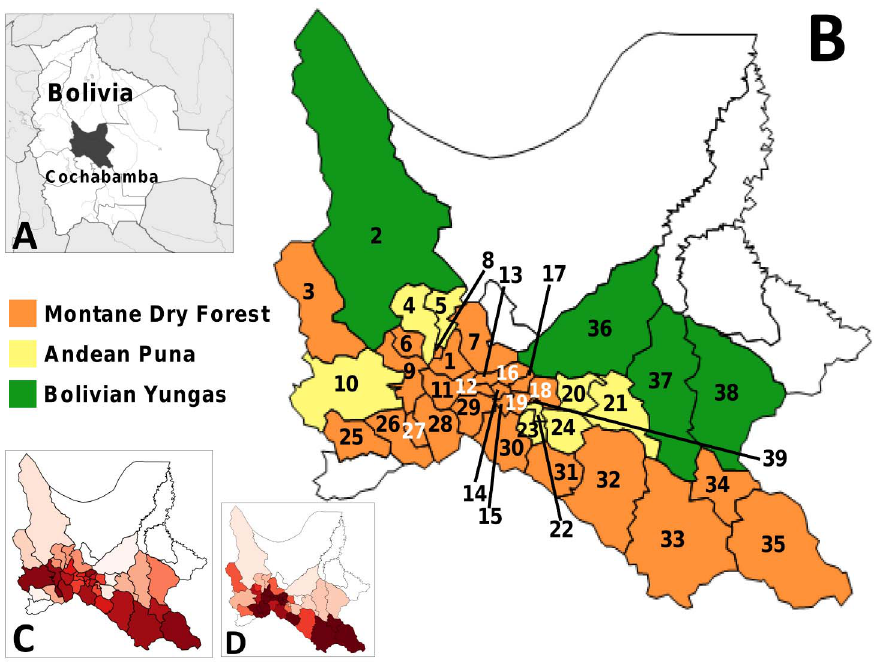
Figure 1. The Department of Cochabamba, Bolivia. A , location of the Department of Cochabamba in Bolivia. B , Municipalities included in the Chagas Disease Control Program (CDCP), and therefore in our assessment, are color-coded according to the predominant ( $ 50% of territory) eco- region. Blank municipalities were not considered at risk by the CDCP and were not included in the analyses. 1, Cercado (includes the capital city, Cochabamba); 2, Morochata; 3, Independencia; 4, Quillacollo; 5, Tiquipaya; 6, Vinto; 7, Sacaba; 8, Colcapirhua; 9, Sipe Sipe; 10, Tapacarı´; 11, Santiva´n˜ez; 12, Arbieto; 13, Tolata; 14, Cliza; 15, Toco; 16, San Benito; 17, Punata; 18, Arani; 19, Villa Rivero; 20, Vacas; 21, Pocona; 22, Cuchumuela; 23, Sacabamba; 24, Alalay; 25, Tacopaya; 26, Arque; 27, Sicaya; 28, Capinota; 29, Tarata; 30, Anzaldo; 31, Vila Vila; 32, Mizque; 33, Aiquile; 34, Omereque; 35, Pasorapa; 36, Tiraque; 37, Totora; 38, Pojo; 39, Tacachi. C , maximum dwelling infestation rates recorded in each municipality over the study period, illustrating overall among-municipality variation in baseline risk. D , percent of municipal territory originally covered by montane dry forest (disregarding deforestation or other land-use changes). In C and D , the color scale goes from 0% (paler/pink) to 100% (darker/red) as in Figure 2.